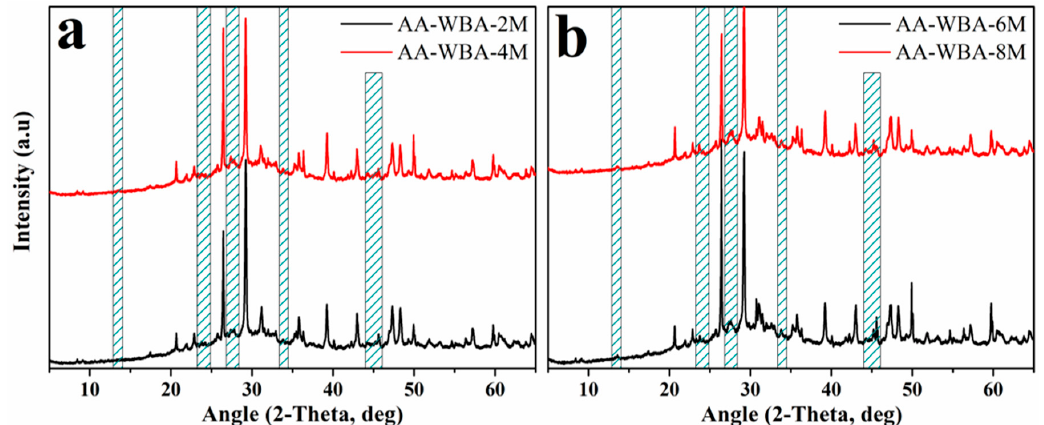
Figure 5. XRD patterns of ( a ) AA-WBA-2M and AA-WBA-4M, and ( b ) AA-WBA-6M and AA-WBA-8M.